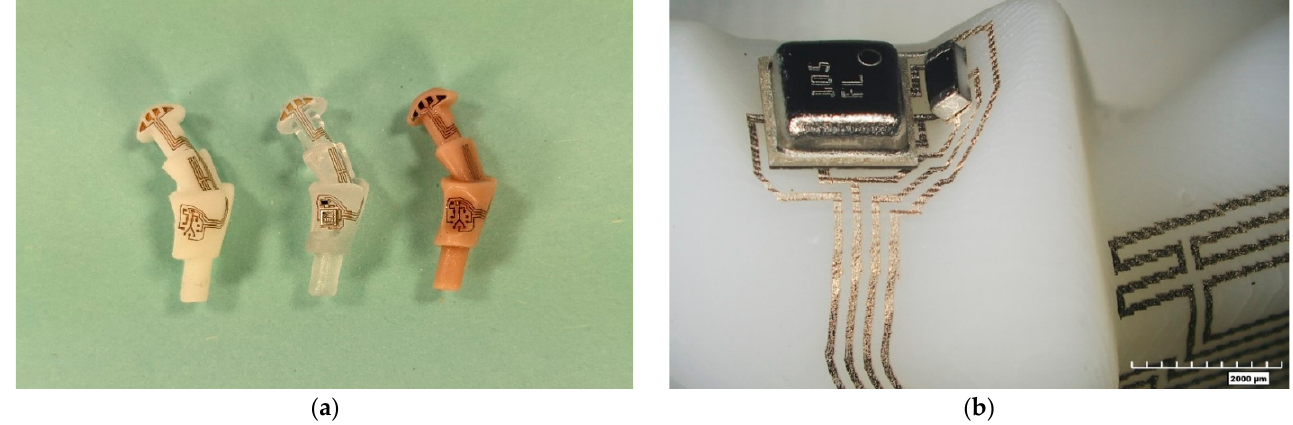
Figure 18. Technology demonstrator with base body made from three different materials ( a ). Detail with assembled pressure sensor and 0603 SMD on PlastCure Rigid10500 substrate by means of ICA ( b